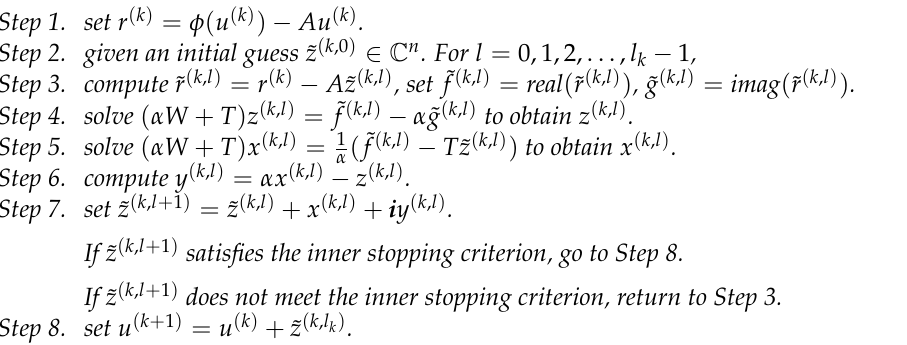
Algorithm 3 (The detailed implementing process of the C-to-R-based Picard iteration method) . Given an initial guess u ( 0 ) ∈ C n and a sequence positive integers { l k } ∞ compute u ( k + 1 ) for k = 0, 1, 2, . . . , until u ( k ) satisfies the stopping